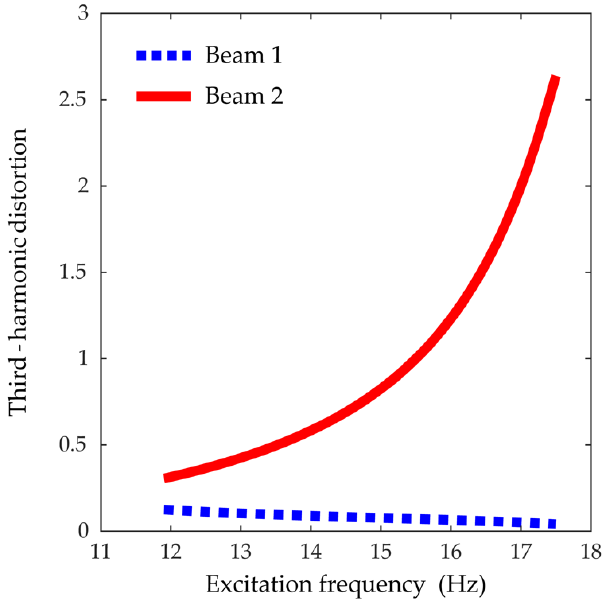
Figure 6. The quantitative third-harmonic distortions, the ratios of the magnitude of the third sinusoidal component to the magnitude of the fundamental component, of the steady-state response in interwell motion. In the calculations, the amplitude of the excitation was set to be 6 m/s 2 .